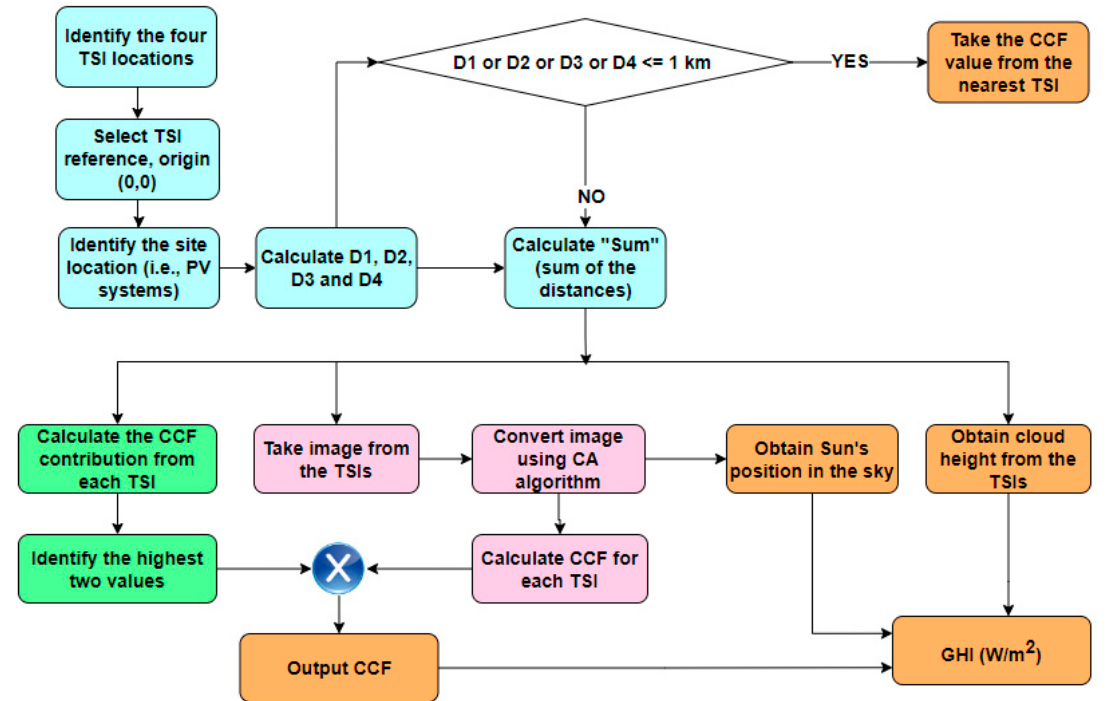
Figure 6. Flowcode of the developed shading ratio approximation algorithm.